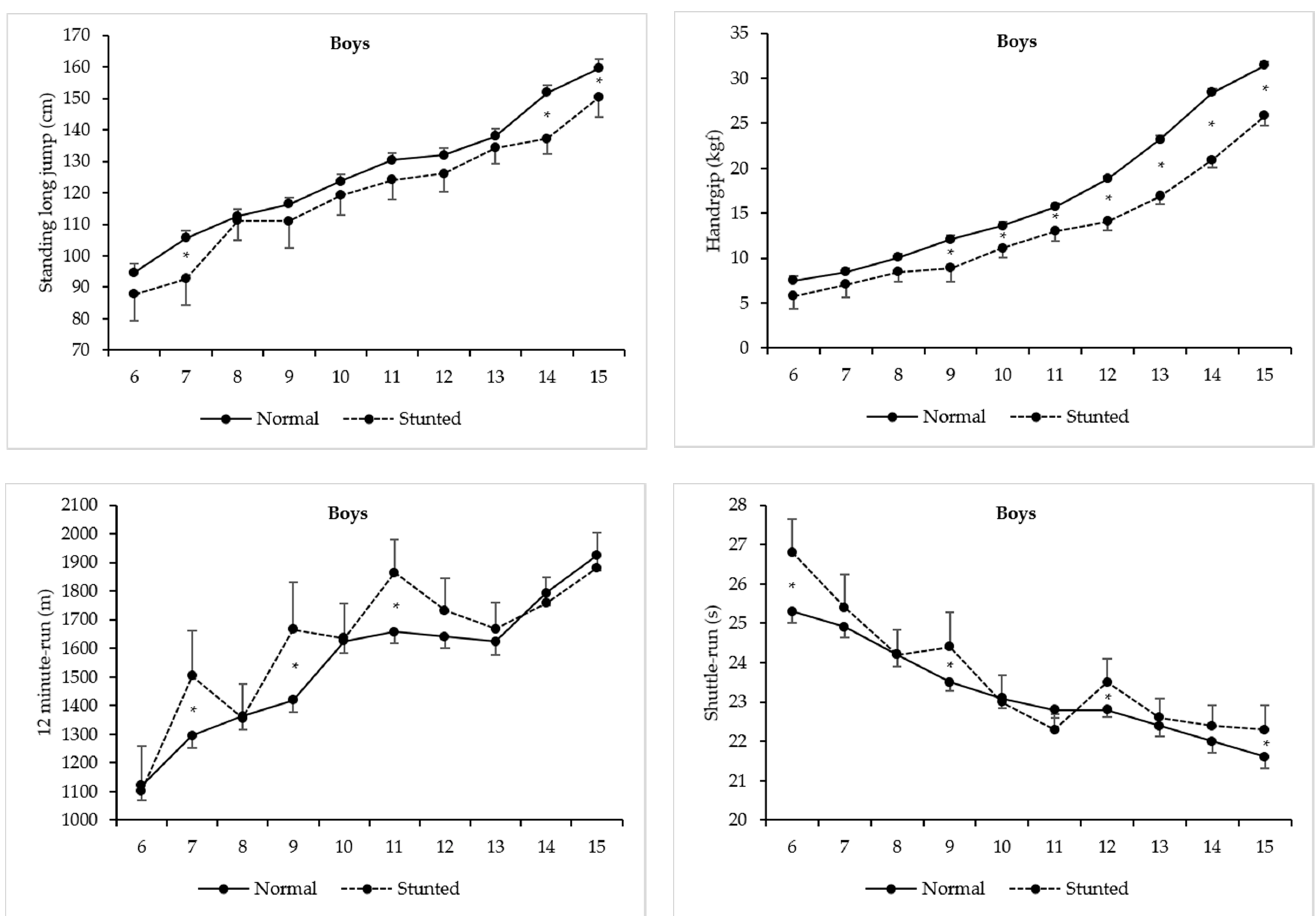
Figure 3. Mean levels for each physical fitness test between stunted and normal-growth Peruvian boys (* marks statistical significant differences; 95% Confidence intervals).